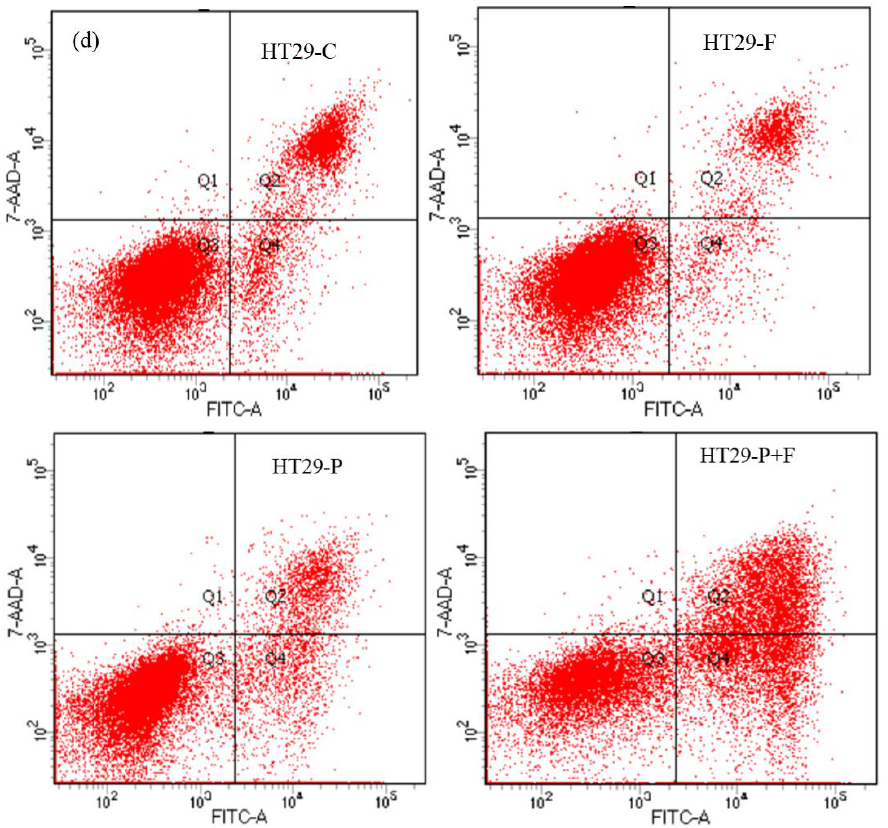
Figure 14. ( a ) Apoptosis assay of the MDA-MB-231 cell line 0 h after the AMF treatment. ( b ) Apoptosis assay of the MDA-MB-231 cell line 24 h after the AMF treatment. ( c ) Apoptosis assay of the HT29 cell line 0 h after the AMF treatment. ( d ) Apoptosis assay of the HT29 cell line 24 h after the AMF treatment.